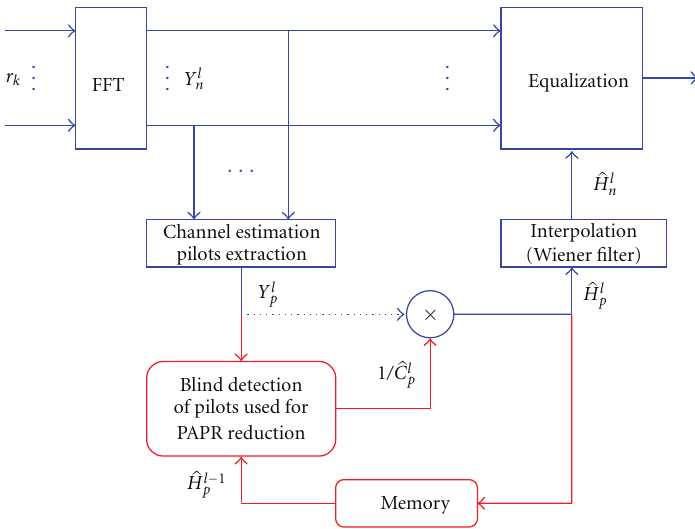
Figure 7: Modified channel estimation